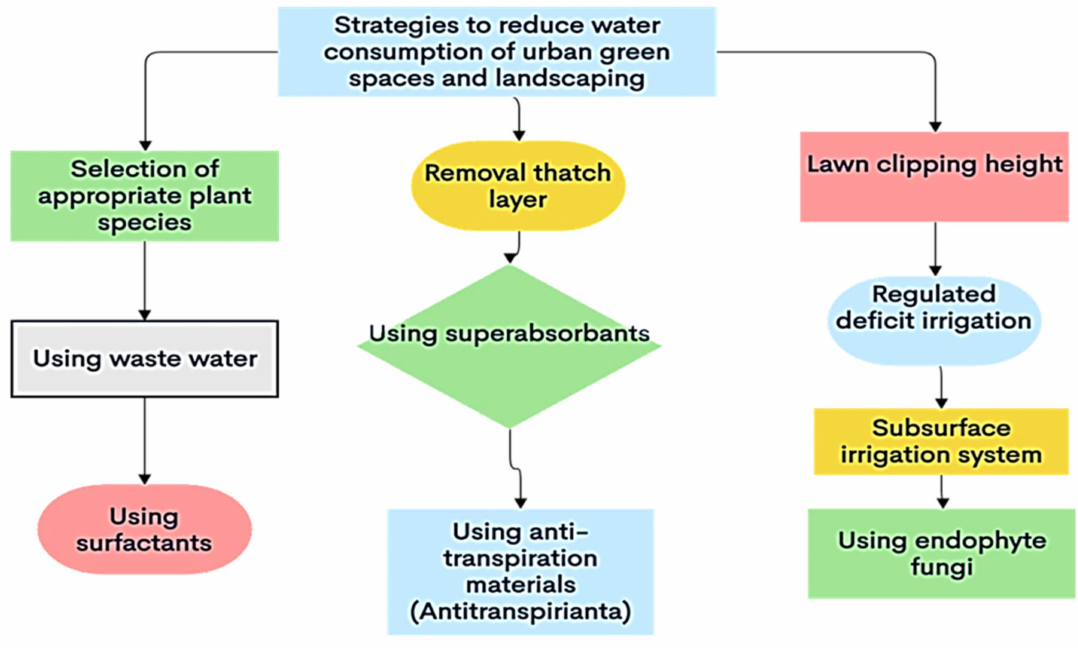
Figure 8. Schematic diagram of strategic water consumption